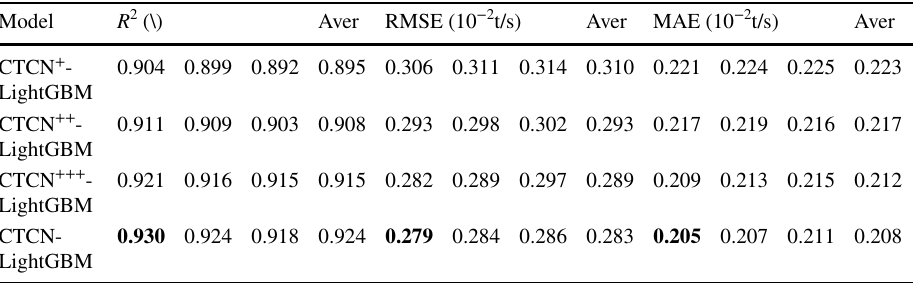
The bold values indicate superior metric values of the proposed CTCN-LightGBM Table 7 Ablation classification modelModel results of each model for the chute flow adjustment